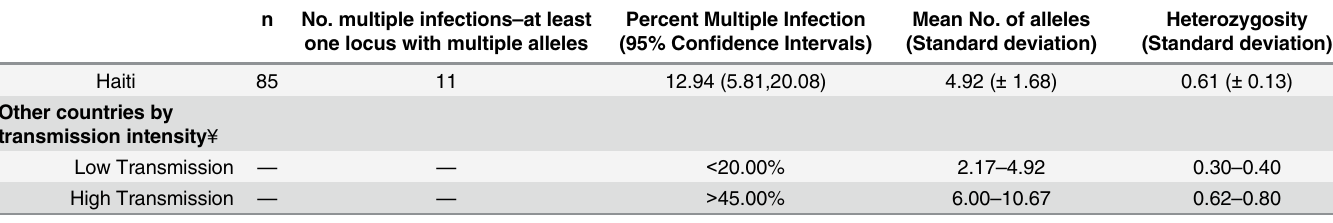
Table 2. Multiplicity of infection, mean number of alleles, and heterozygosity in Haiti compared to ranges observed in high and low malaria trans- mission populations. n